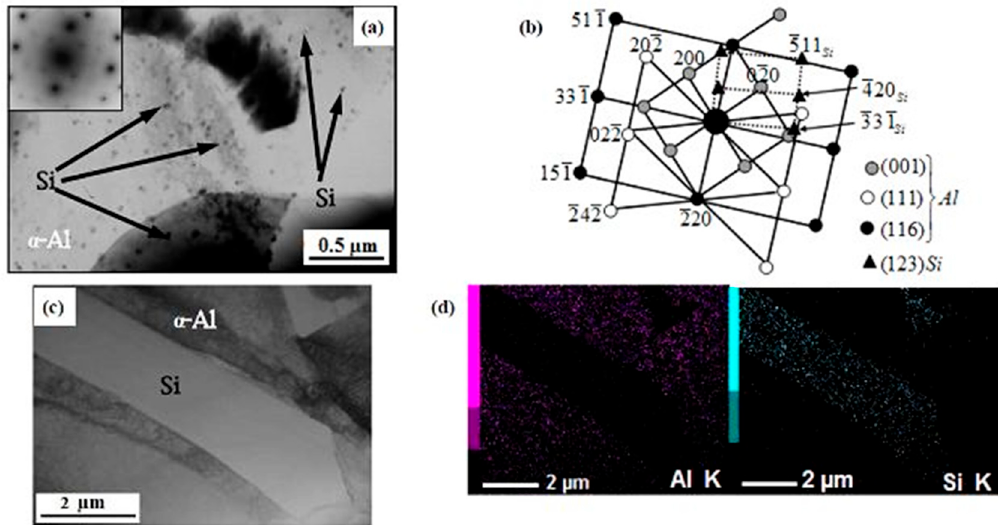
Figure 3. TEM image of the Al-7%Si alloy after the introduction of 0.4 mass. % UFP: ( a ) a bright-field image and its microdiffraction pattern of the section of the α -Al grain with precipitations of secondary Si; ( b ) an indexed scheme of the modifying mixture (MM) of section ( a ); ( c ) a bright-field image of the section of the eutectic region containing acicular Si crystals; ( d ) mapping of section ( c ).